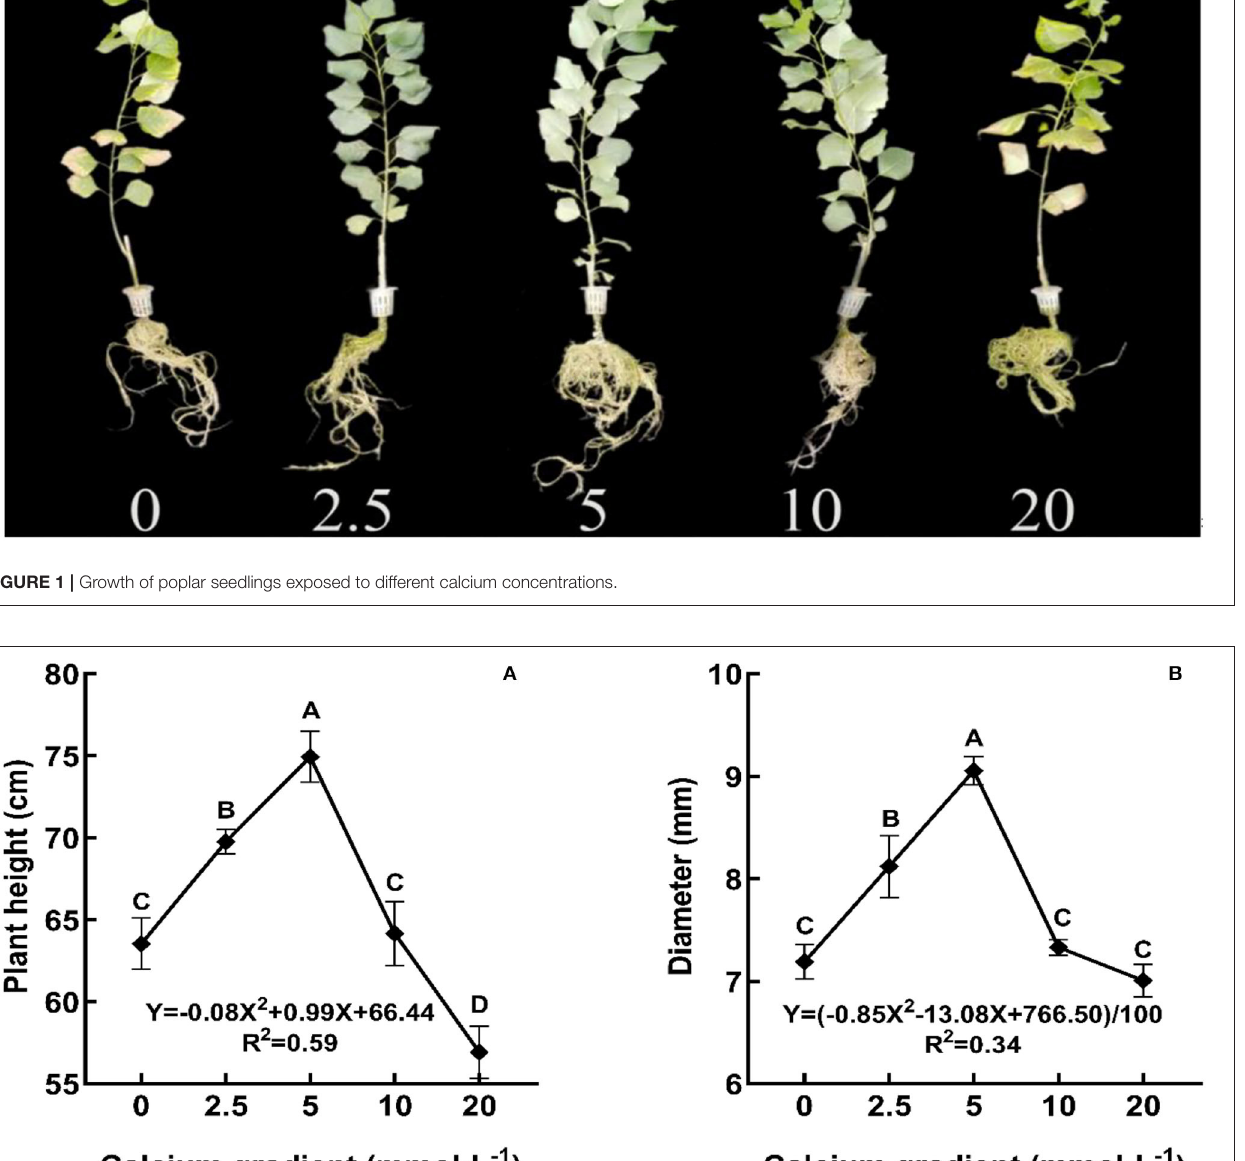
and 16.01%, respectively, compared to no calcium